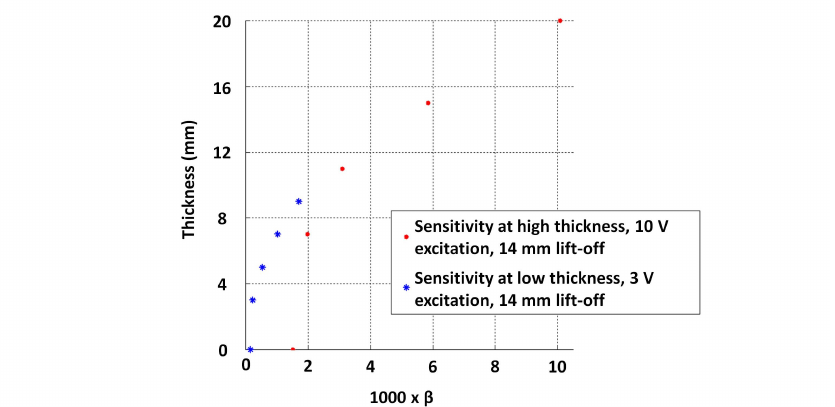
Figure 20. Low and high thickness regions captured with different excitation strengths merging to form a continuous function in the feature